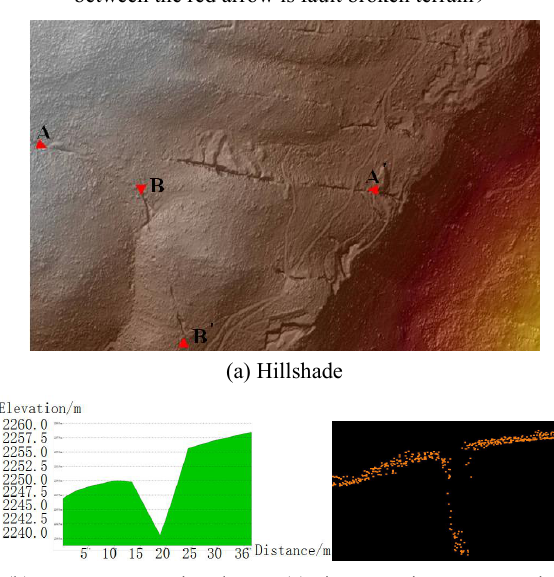
Fig.8 Display of micro-features of faults （ Characteristic between the red arrow is fault broken terrain ）